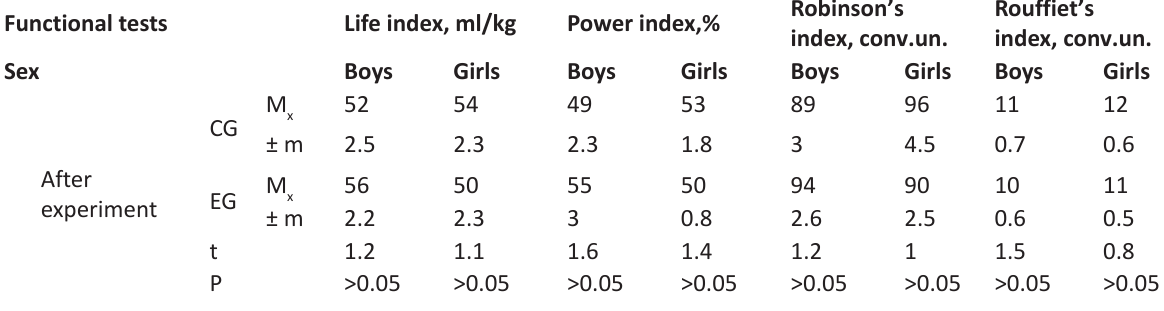
Table 2. Students’ mastery of basketball basic techniques Techniques